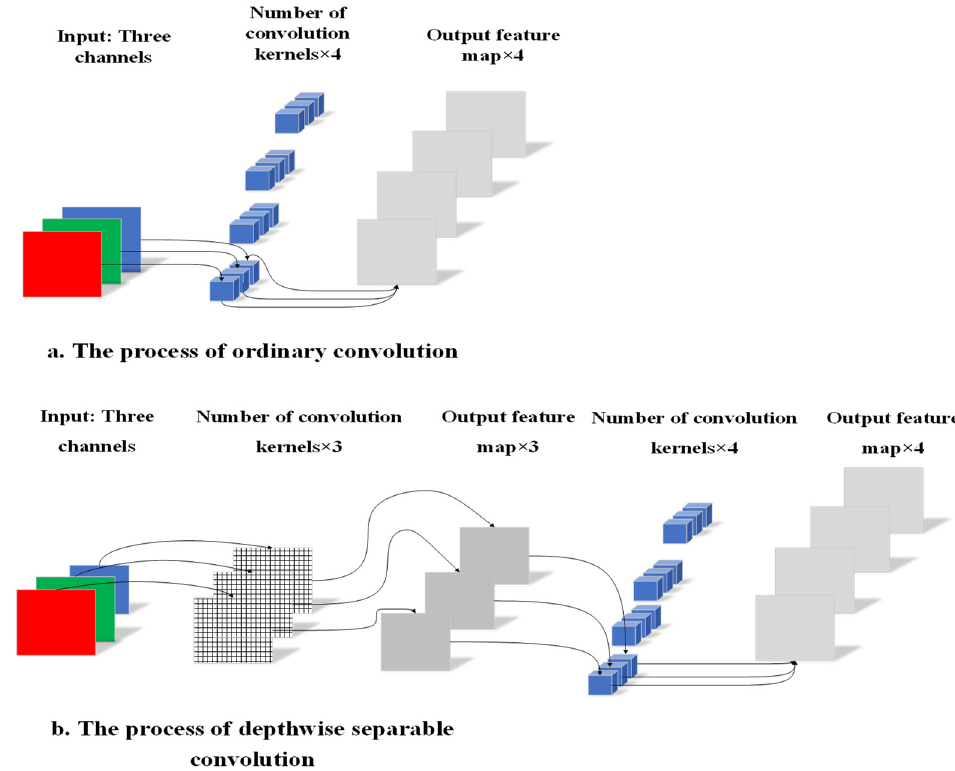
Figure 5. Ordinary convolution and depthwise separable convolution.